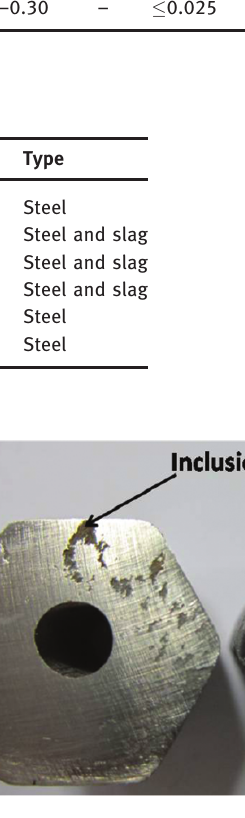
Figure 1: Fracture morphology.